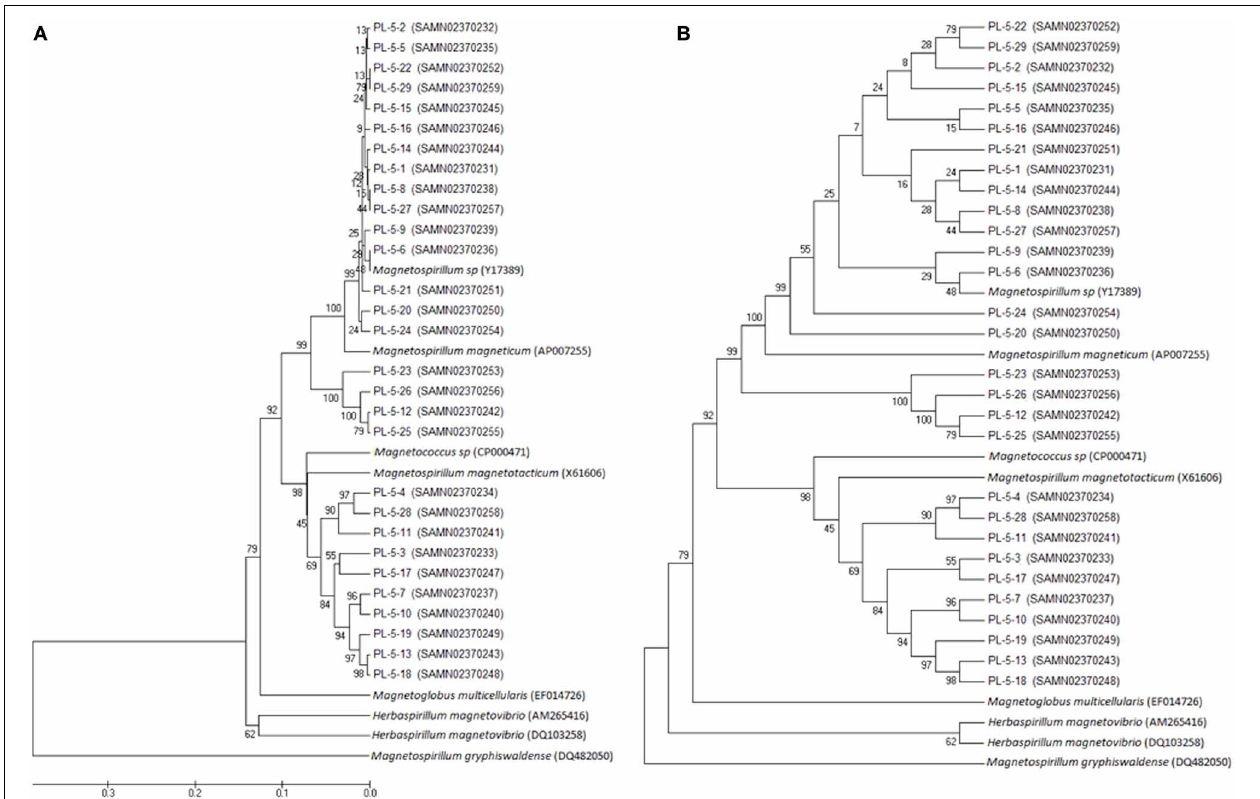
FIGURE 2 | Phylogenetic tree from twenty-nine 16S rRNA sequences of bacteria isolated from Pavilion Lake, British Columbia. (A) The evolutionary history for this Original Tree was inferred using the UPGMA method (Sneath and Sokal, 1973). The optimal tree with the sum of branch length = 1.85273957 is shown. The percentage of replicate trees in which the associated taxa clustered together in the bootstrap test (500 replicates) are shown next to the branches (Felsenstein, 1985). The tree is drawn to scale, with branch lengths in the same units as those of the evolutionary distances used to infer